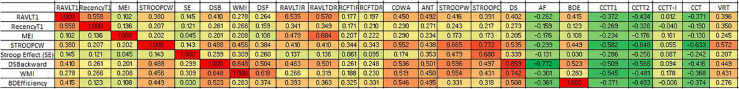
Correlation heat map showing association of working memory with other cognitive domains.